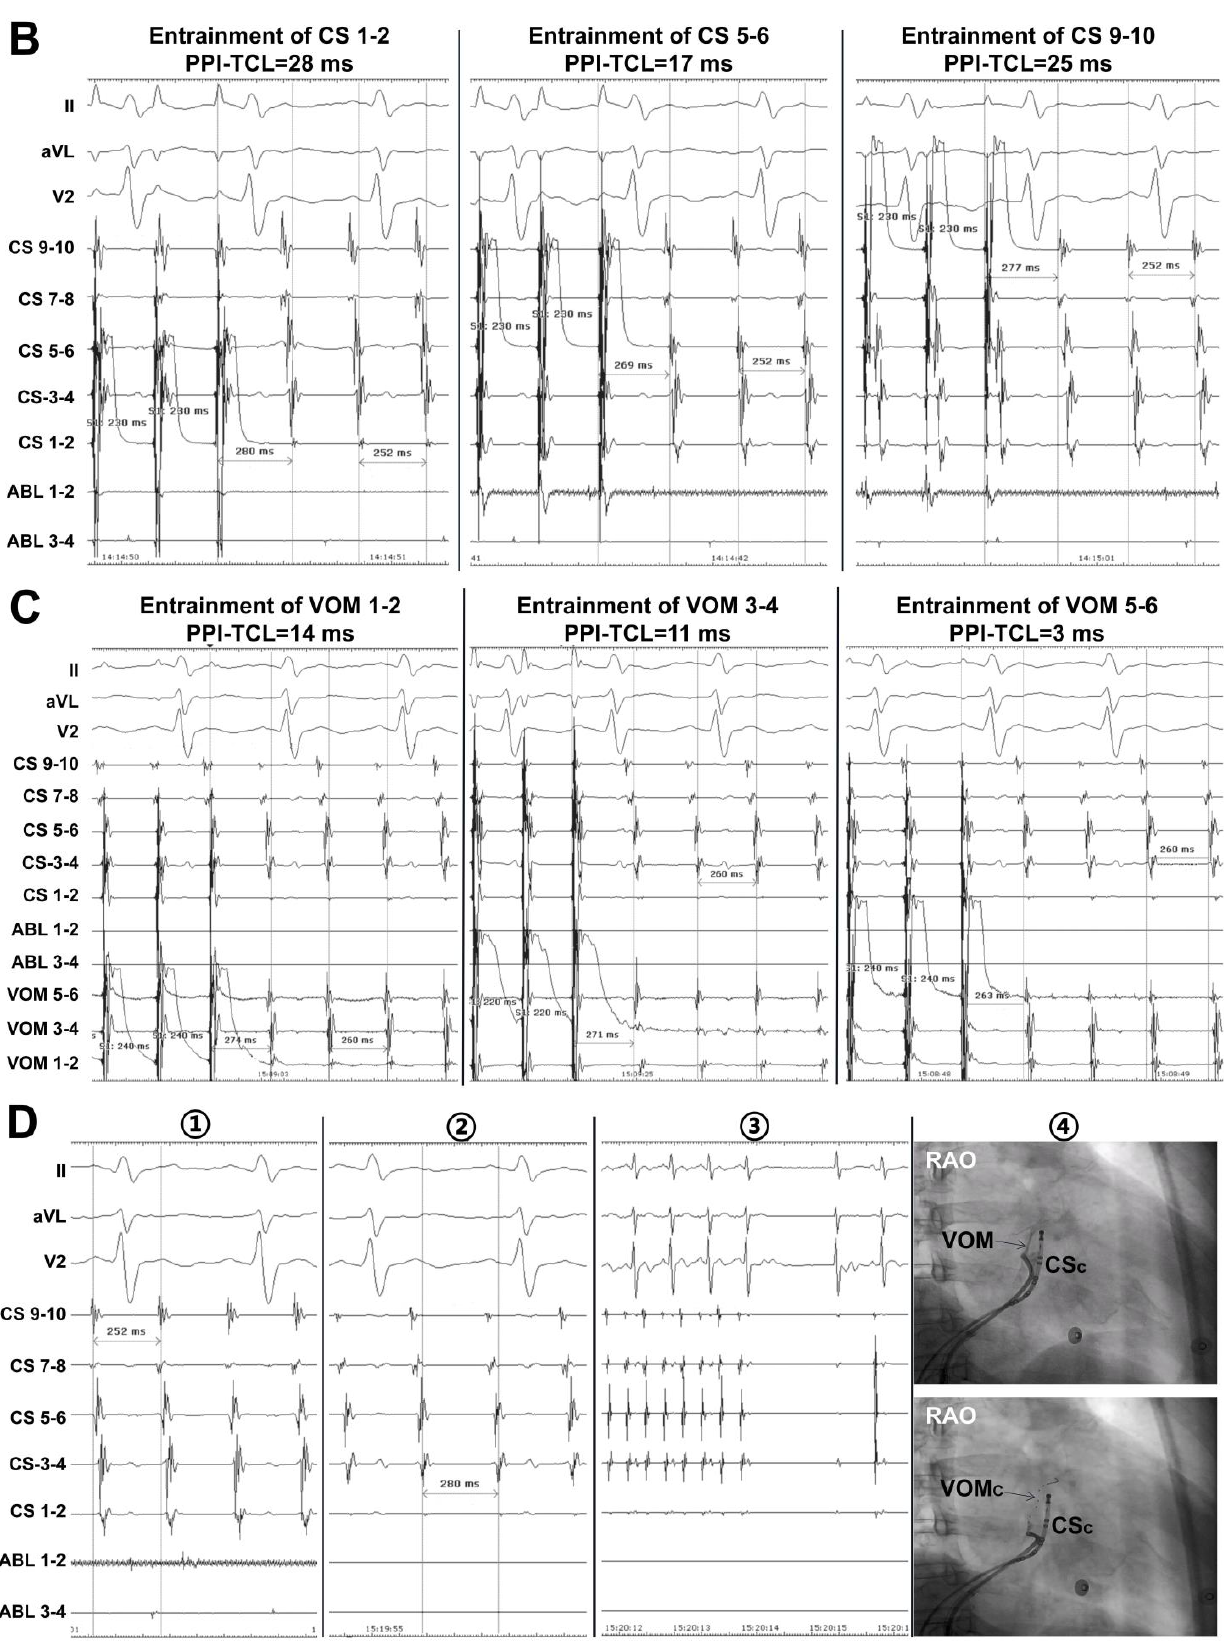
Figure 3. Perimitral flutter mediated by VOM epicardial connections in a persistent atrial fibrillation patient undergoing PVI and linear ablation. ( A ) Activation mapping of the left atrium ( ①) and right atrium ( ② ), and entrainment mapping of the left atrium ( ③ ～ ⑥ ). Activation mapping of the left atrium indicated a focal activation mode, and the earliest atrial activation was located at the anterior roof. The total activation time of the left atrium was 201 ms, less than the TCL of 252 ms. Activation mapping of the right atrium showed that the right atrium was passively activated by the left atrium. Entrainment from MI ( ③ and ④ ) produced significantly prolonged PPI (PPI ﹣ TCL = 72 ms in ③ ; PPI ﹣ TCL = 82 ms in ④ ), while entrainment from the anterior roof ( ⑤ ) and posterior inferior wall near the CS ( ⑥ ) produced short PPIs (PPI ﹣ TCL = 12 ms in ⑤ ; PPI ﹣ TCL = 7 ms in ⑥ ). ( B ) Entrainment from CS produced short PPIs. ( C ) Entrainment from VOM also produced short PPIs. The activation mapping and entrainment mapping indicated that the tachycardia was MI- dependent with an epicardial connection (VOM). ( D ) Selective VOM venography prolonged the TCL without terminating the tachycardia ( ① and ② ). Injection of 2 mL of ethanol into VOM terminated the tachycardia ( ③ ). Fluoroscopic images of a VOM venogram and VOM catheter (VOMc) were shown in right anterior oblique (RAO) view ( ④ ). PVI, pulmonary vein isolation; VOM, vein of Marshall; TCL, tachycardia cycle length; MI, mitral isthmus; PPI, postpacing interval; CS, coronary sinus. 6. The Challenge and Importance of MI Block